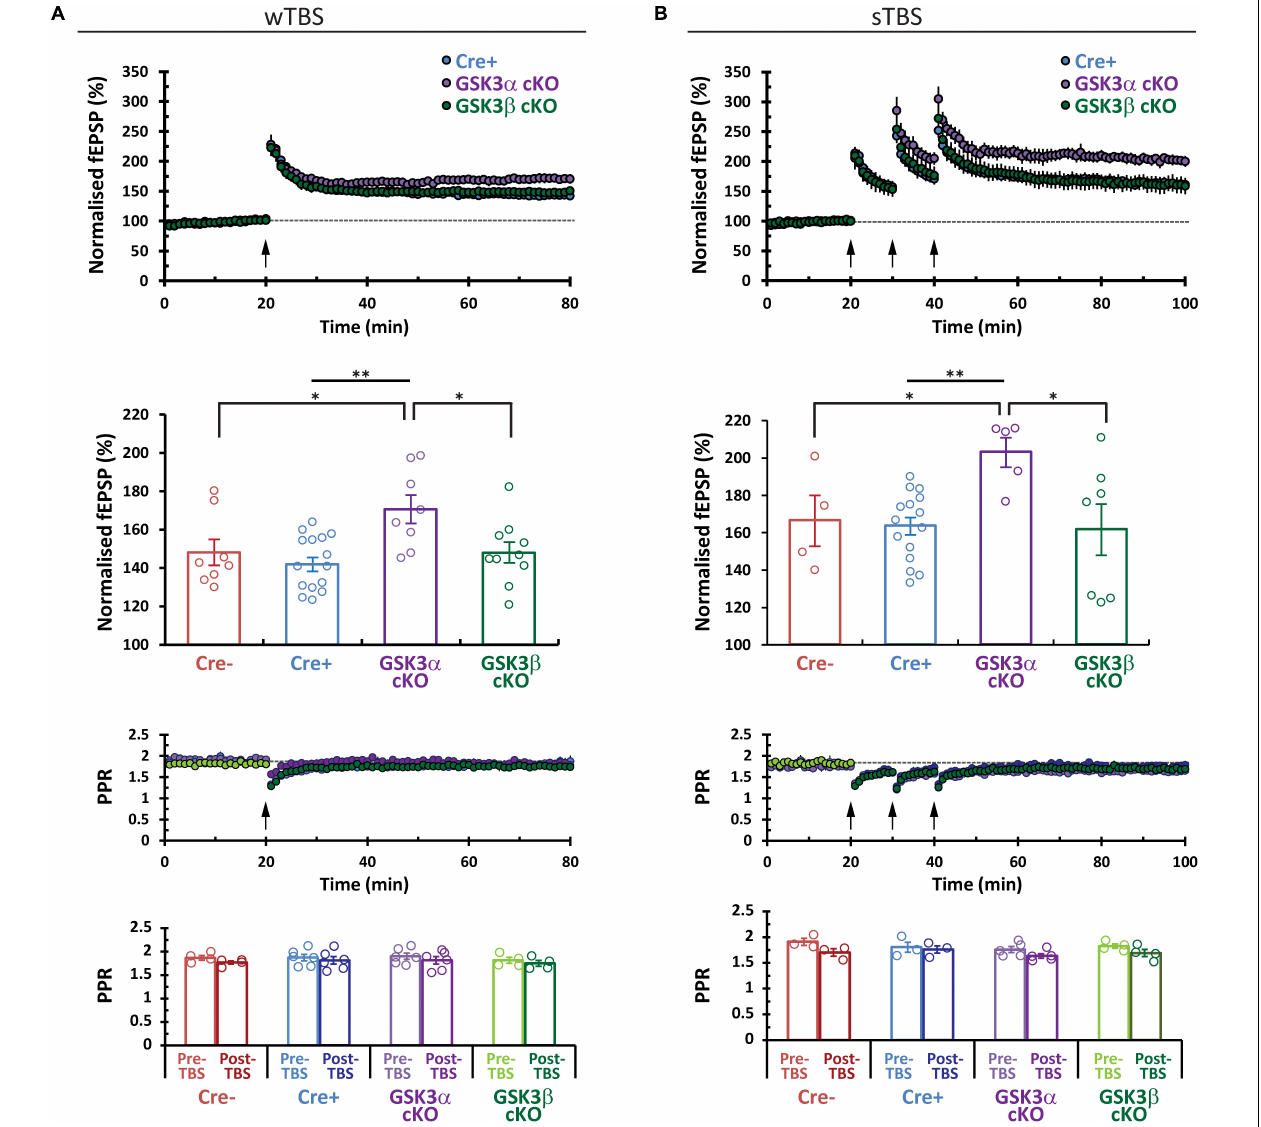
FIGURE 5 | GSK3 α cKOs show a selective increase in CA3–CA1 LTP. Comparison of the averaged LTP data sets for (A) wTBS and (B) sTBS (3 × TBS) induction protocols. Corresponding bar plot summary (second row) shows the LTP level achieved at the last 10 min of each experimental series (normalized to the 10 min